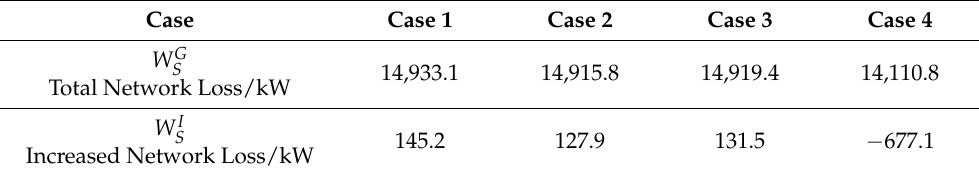
Table 9. Comparison of network loss in the four cases on another day.